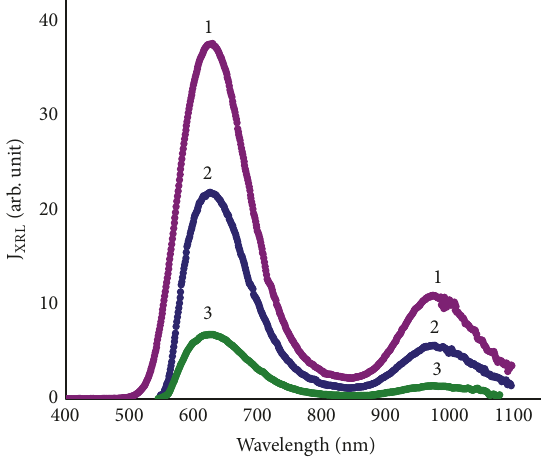
Figure 3: The distinctive XRL spectra of the ZnSe single crystal at the temperature of 295 K under different levels of excitation: the current of the X-ray tube, 25mA (1) ; 15mA (2) ; and 5mA (3)